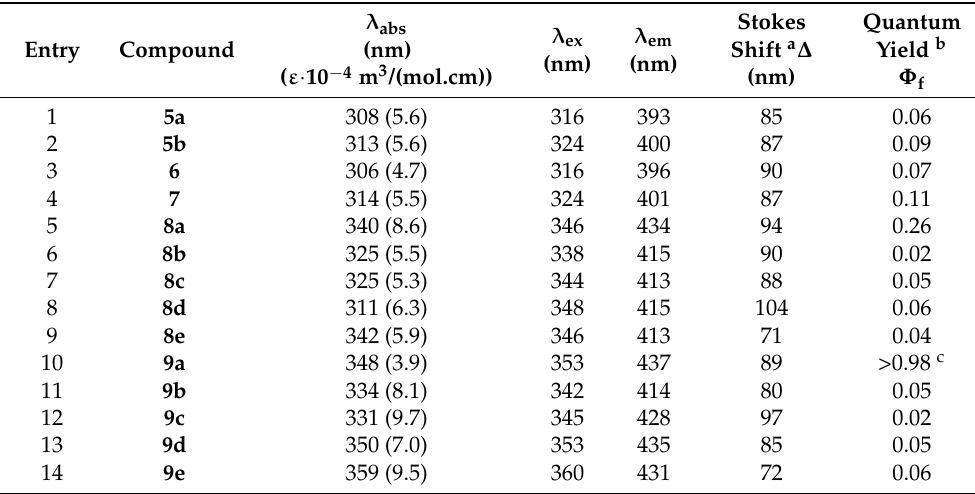
Table 4. Spectroscopic data for the studied compounds 5a , 5b , 6 , 7 , 8a – e , 9a – e .